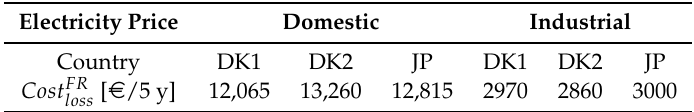
Table 3. Cost FR for 5-year period of frequency regulation, due to the charging and discharging loss charger loss.